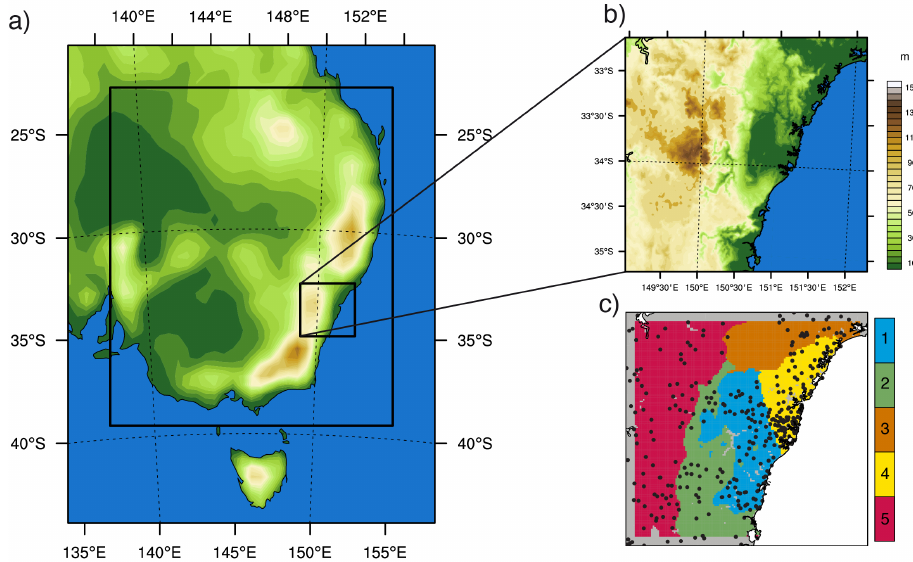
Fig. 1. (a) Topography and location of all domains of the simulation, (b) topography and extension of the inner domain, and (c) location of the stations (black dots) and the 5 different precipitation regions (colored areas) within the model domain.